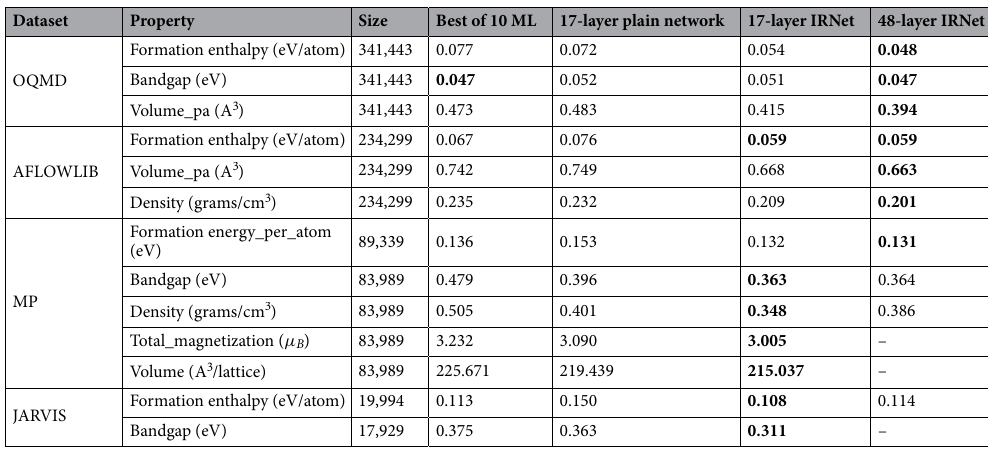
Table 1. Performance benchmarking for the prediction task of “materials property given composition”. The number in bold font represents the best model performance for a given combination of dataset, materials property and model input (each row).